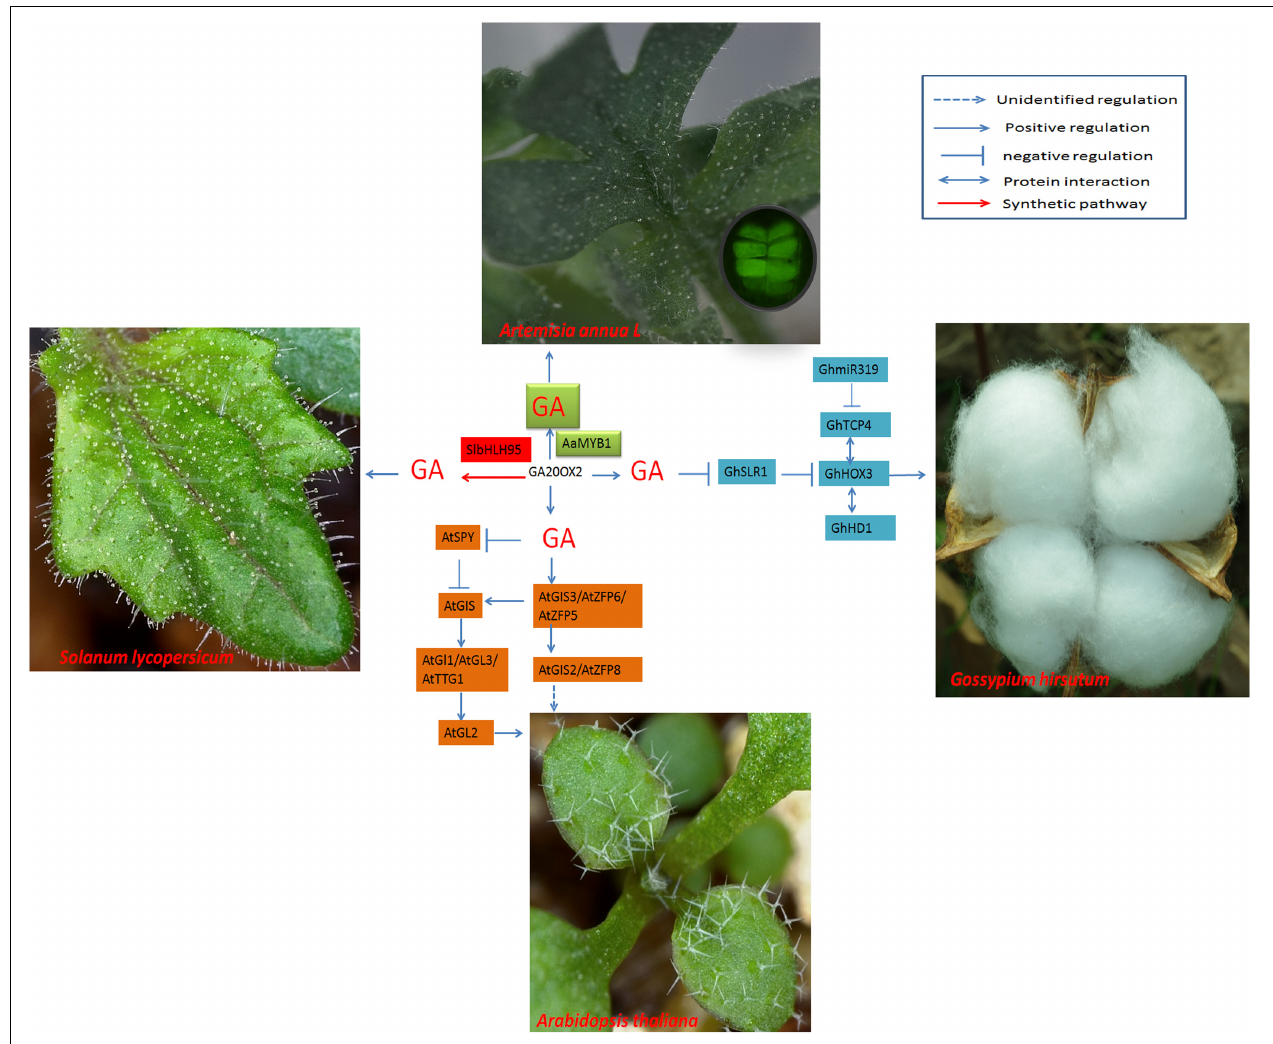
FIGURE 4 | Regulatory networks of cotton fiber and trichome development induced by GA. GA20ox2 is the key enzyme that affects GA content and promotes trichome development. Modulation of GA20ox2 by SlbHLH95 in tomato or by AaMYB1 in A. annua affects trichome